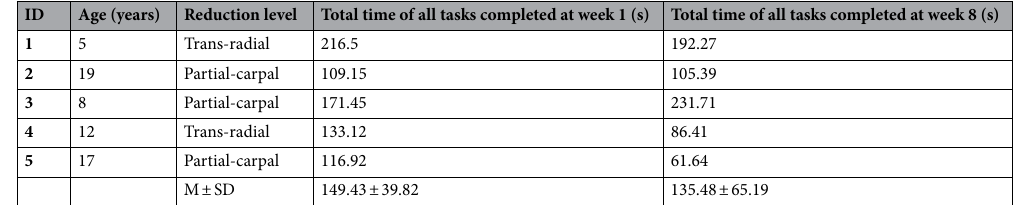
Table 1. Congenital upper limb reduction participant demographics and week 1/week 8 total time of activities performed throughout training intervention.